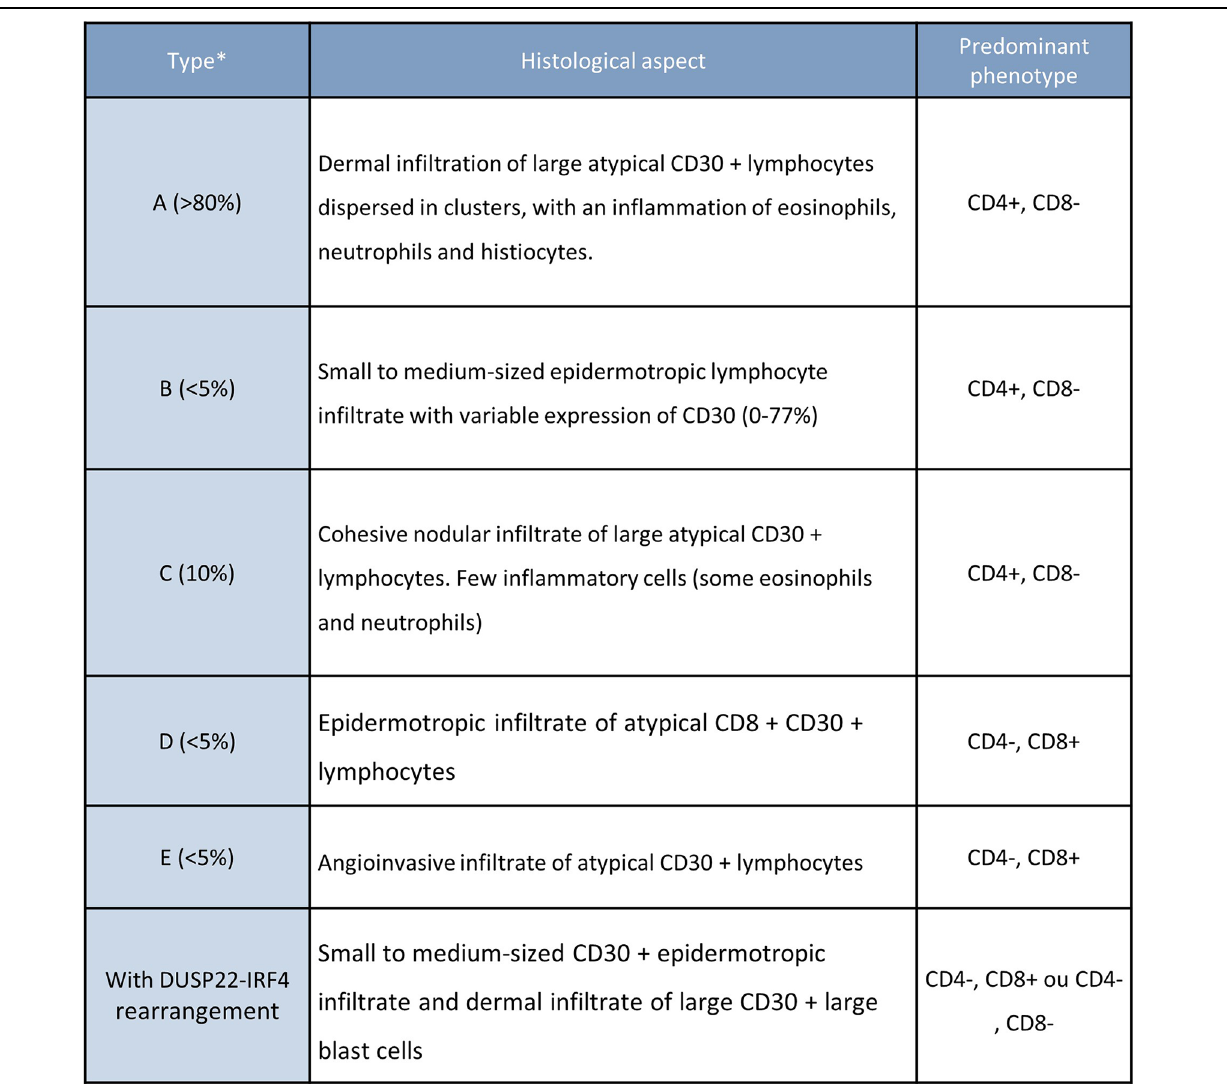
Table I. LyP = Histological subtypes, predominant